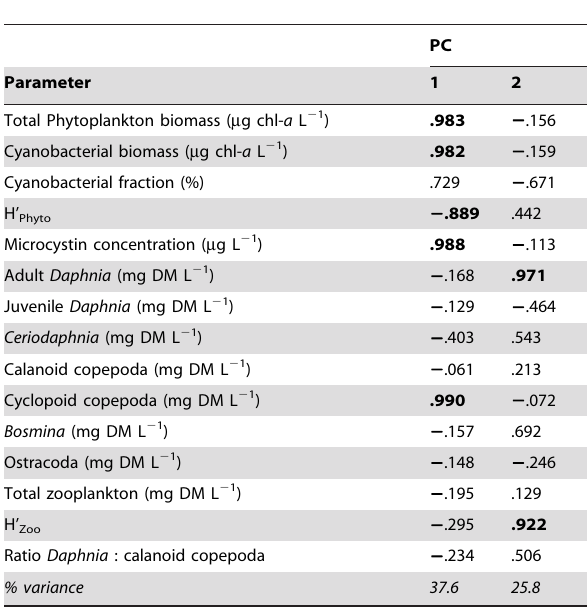
Table 5. Principal component